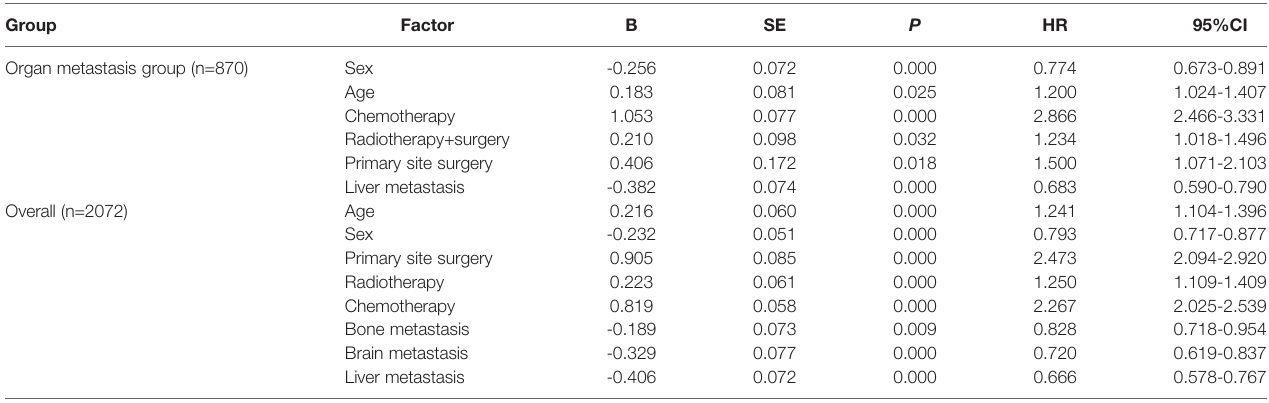
Organ metastasis group: Multivariate cox regression analysis showed that sex (P 0.000 HR 0.774, 95%CI 0.673 – 0.891), radiotherapy +surgery (P 0.032 HR 1.234, 95%CI 1.018 – 1.496), chemotherapy (p0.000HR2.866,95%CI2.466 – 3.331),age(P0.025HR1.200,95%CI1.024 – 1.407),primarysitesurgery(P0.018HR1.500,95%CI1.071 – 2.103),andlivermetastasis